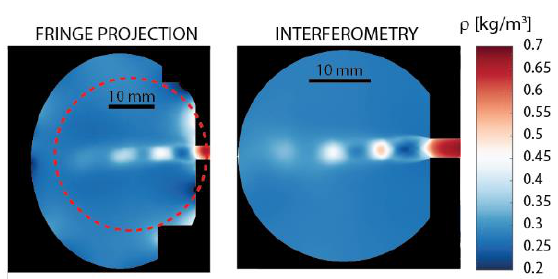
Fig. 7. Density distribution computed from slope maps measured by the fringe projection (left), and density distribution measured directly by interferometry